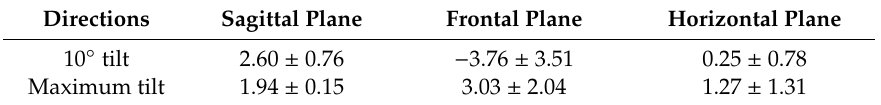
Table 4. Rate of change in NPHE and MPHE during PHE (MPHE / NPHE).